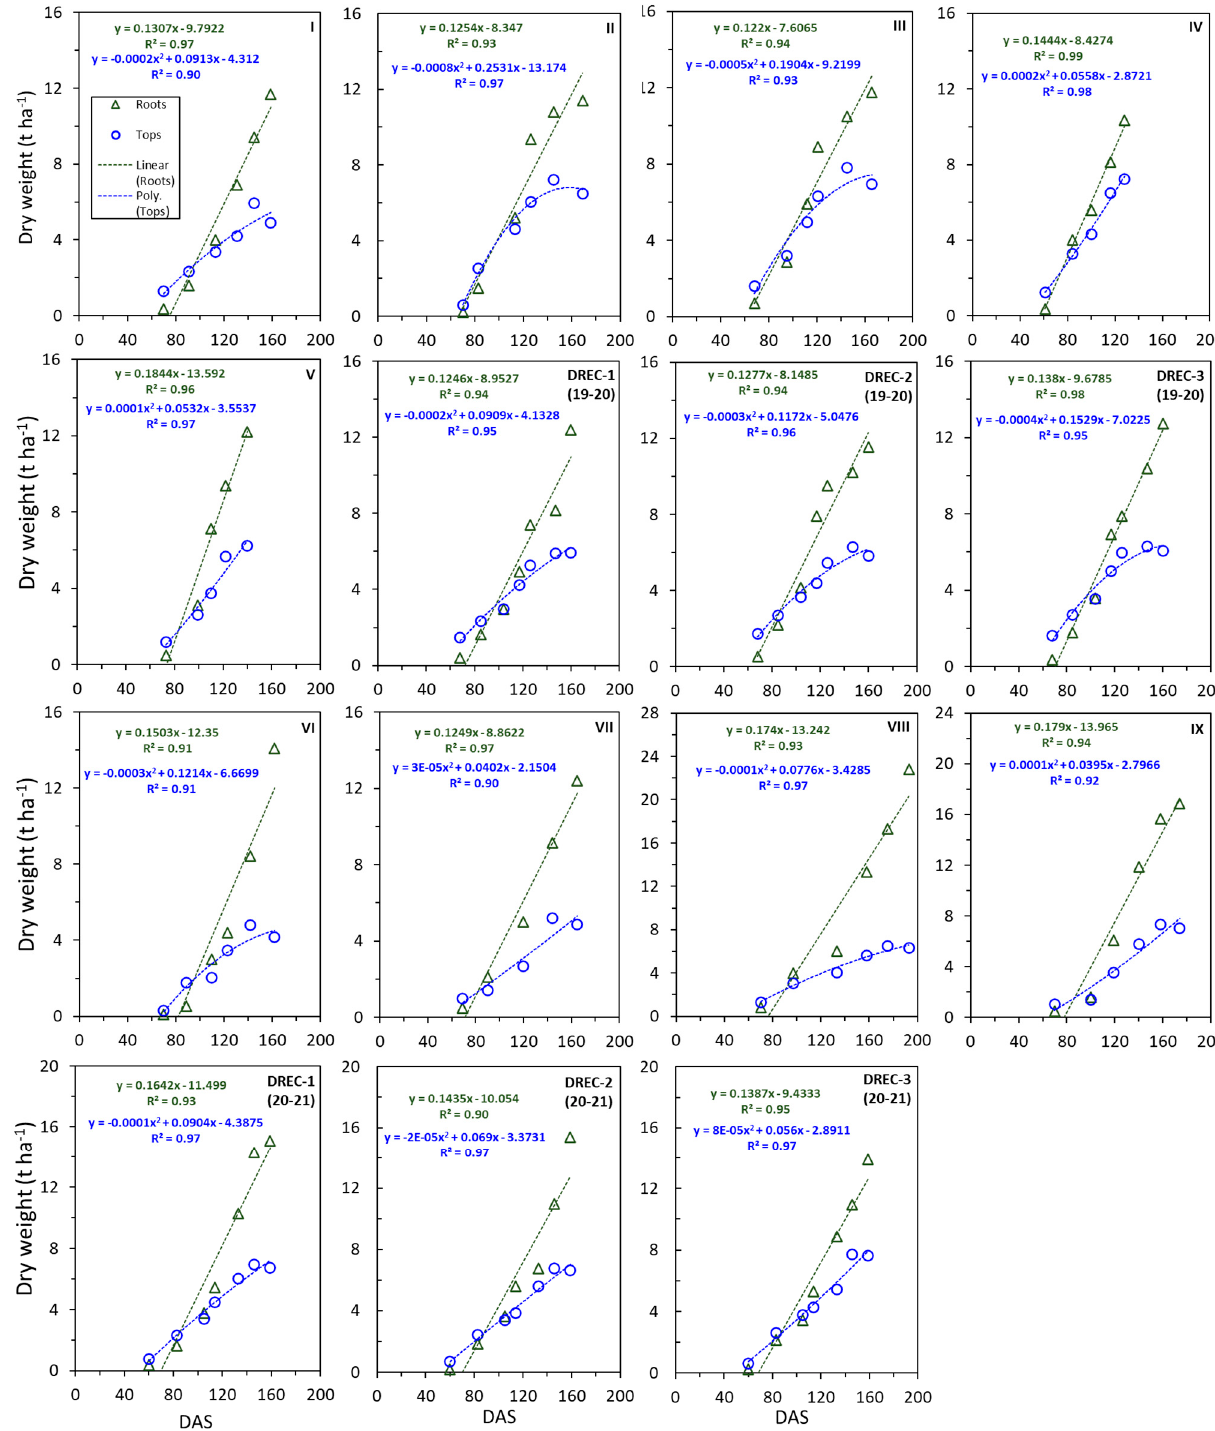
Figure 9. Dry matter accumulation during the growing season for tops and storage roots at the experimental sites.